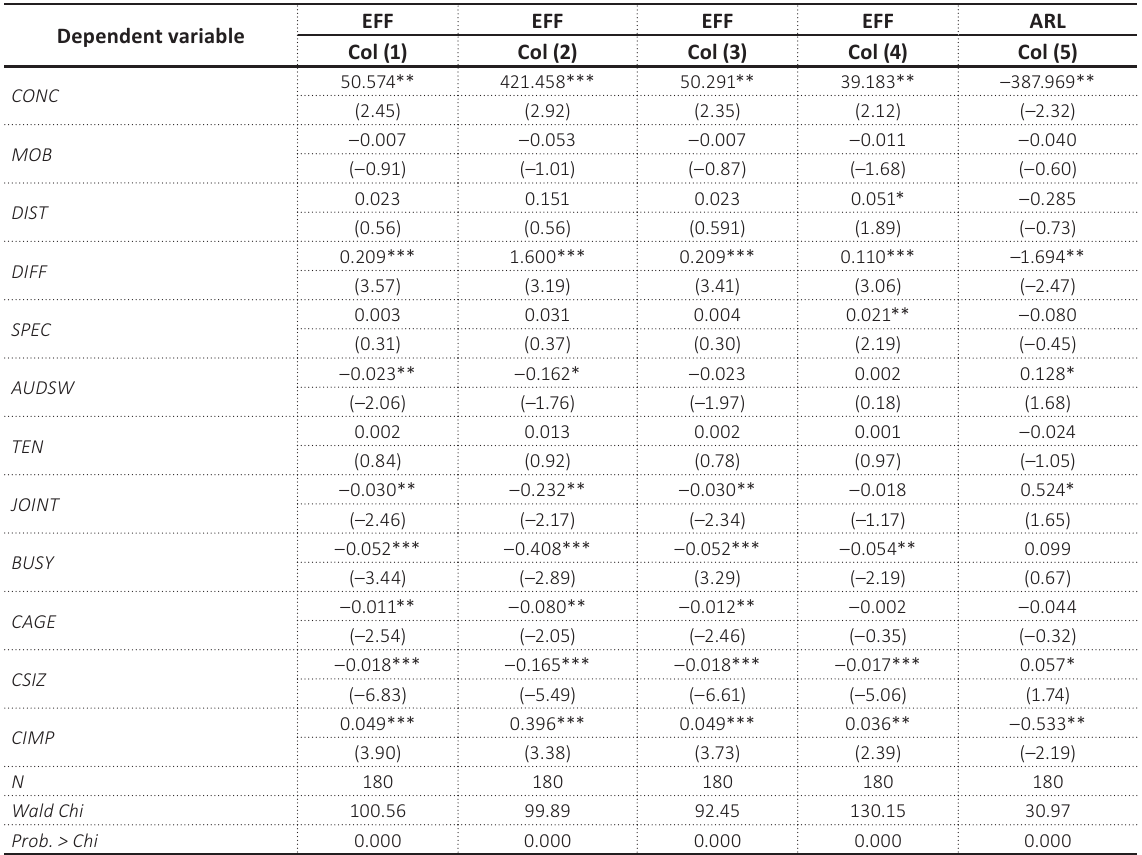
Table 4. Regression